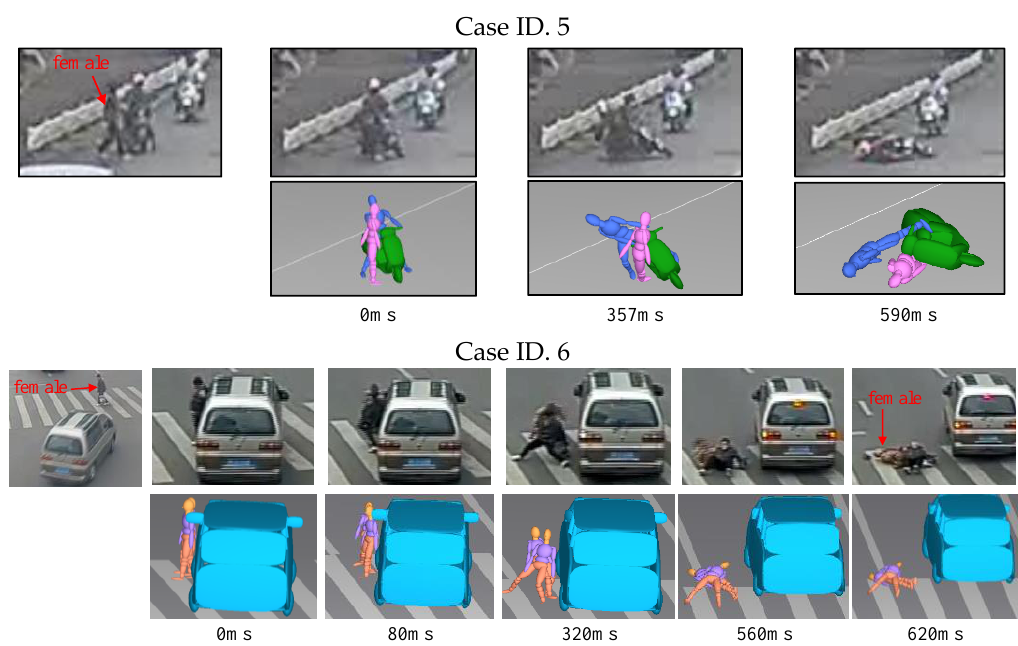
Figure A1. Comparison of reconstructed kinematics with video screenshots. The pedestrian’s body is blurred in the screenshot, but the body can be clearly judged in the video.